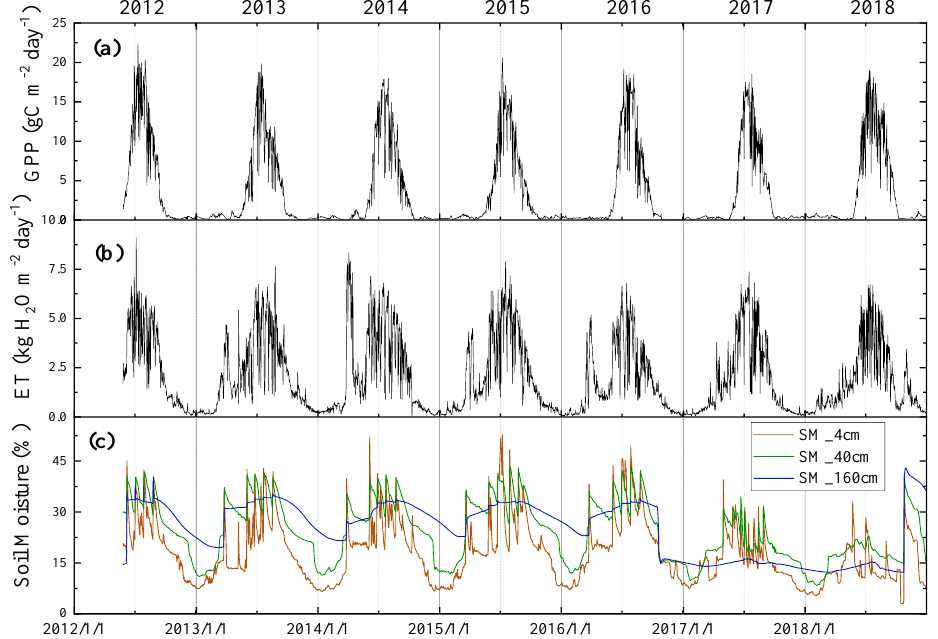
Figure 4. Temporal variations in daily gross primary production (GPP) ( a ), evapotranspiration (ET) ( b ), and soil moisture (SM)( c ) at different depths. Before 2017, flood-irrigation were used in the study site, while the drip irrigation were performed since the beginning of growing season in 2017.